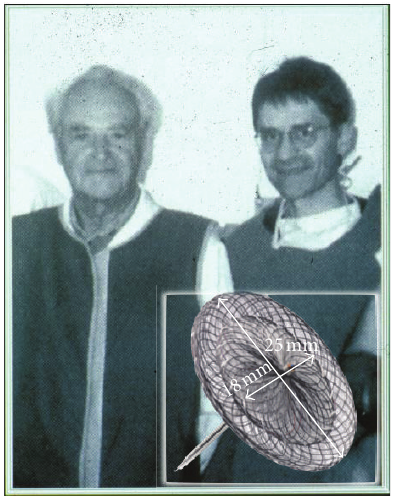
Figure 1: Kurt Amplatz (left) and Bernhard Meier (right) on the occasion of the world’s first closure of a patent foramen ovale using an Amplatzer PFO occluder (insert) on September 10, 1997, in Switzerland.